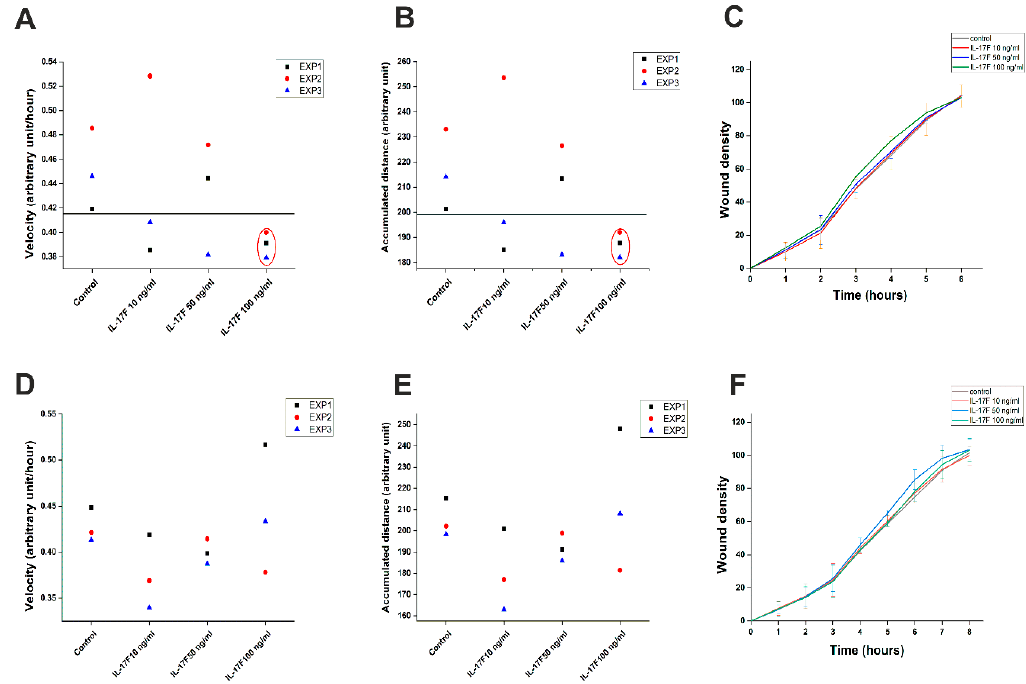
Figure 4. IL-17F reduces random migration in highly invasive HSC-3 cells. ( A ) 100 ng/mL of IL-17F reduced the random migration velocity of the highly invasive HSC-3 cell line compared with the non-stimulated controls. ( B ) 100 ng/mL of IL-17F reduced the accumulated distance of the highly invasive HSC-3 cell line compared with the non-stimulated controls. ( C ) IL-17F had no observable e ff ect on the directed migration (wound density) of HSC-3 cells. ( D – F ) IL-17F did not a ff ect the random (velocity and accumulated distance) or directed migration (wound density) of low-invasive SCC-25 cells. Data are presented as means ± standard